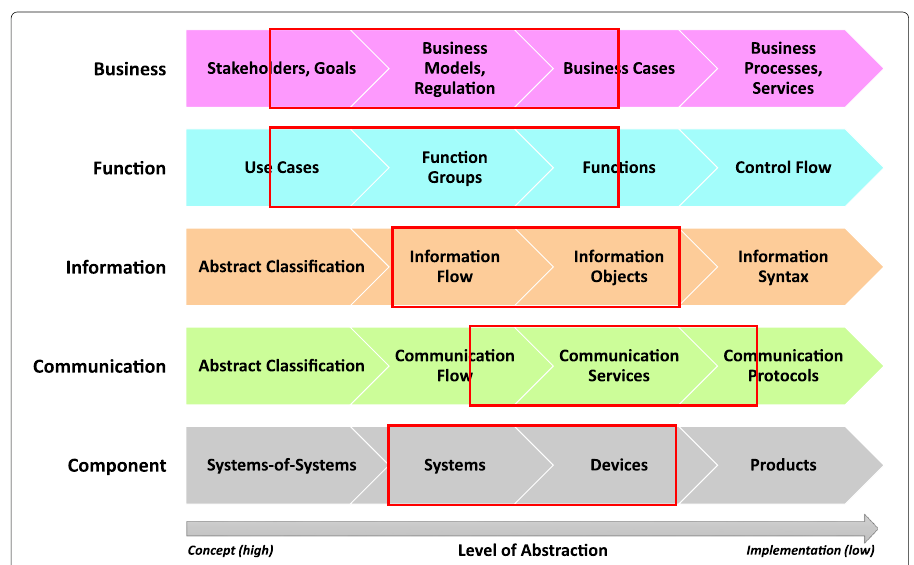
Fig. 10 Level of abstraction adopted from SGAM CEN-CENELEC-ETSI Smart Grid Coordination Group (2014), as applied in the ELECTRIFIC case study